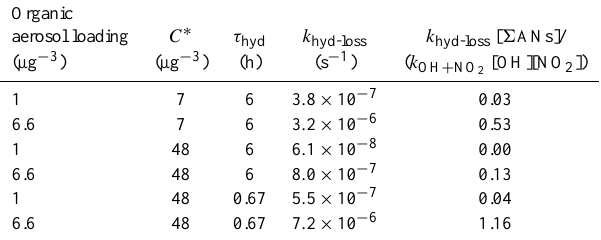
Table 3. Median calculated loss rate of 6 ANs due to hydrolysis in the particle phase assuming that only monoterpene nitrates may partition into the aerosol and hydrolyze. We consider cases that span different vapor pressures, hydrolysis rates, and organic aerosol loadings. Here, C ∗ represents the effective saturation concentration, τ hyd is the lifetime to hydrolysis for a tertiary nitrate in the particle phase, k hyd-loss is the calculated loss rate of 6 ANs via hydrolysis (see text for details), and the last column is the median of the ratio of this HNO 3 source to the source from the reaction of OH with NO 2 . After correction for the small alkyl nitrates, monoterpenes accounted for ∼ 10% ( ∼ 19%) (median value) of the 6 ANs in the low (high) aerosol loading periods. We assume that only a fraction (75%) of the monoterpene nitrates undergo hydrolysis and thus the fraction of the 6 ANs that are in the particle phase and undergoing hydrolysis is 2–7% for the high loadings and < 1% for the low loadings. Organic aerosol